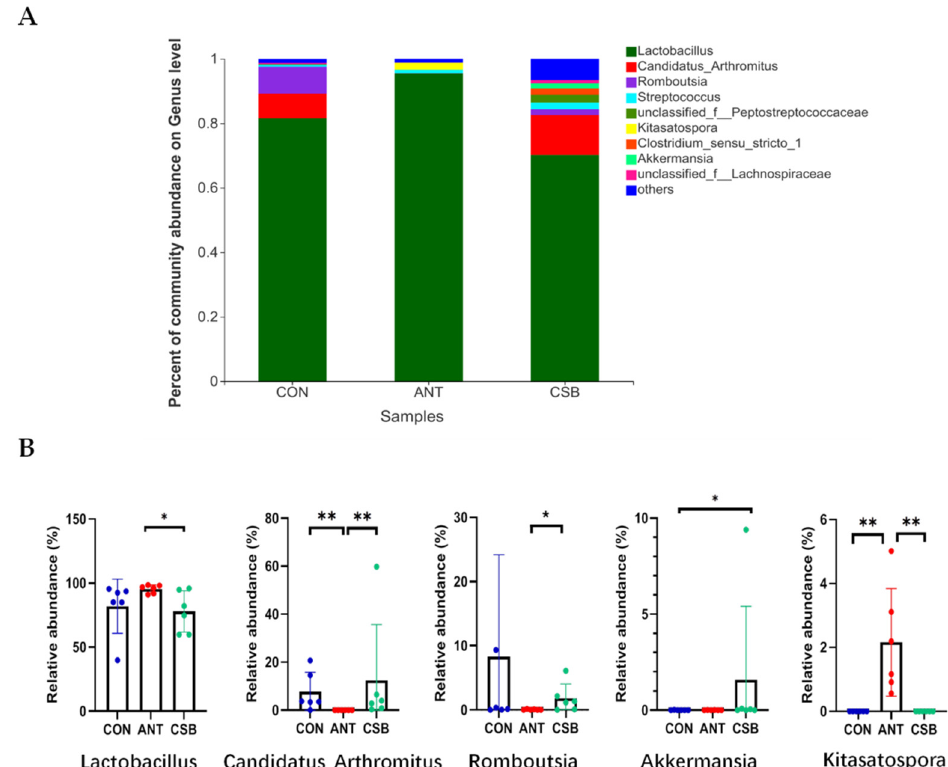
Figure 7. Effects of CSB on the ileal microbial community at the genus level in broilers at 21 d of age ( n = 6). ( A ) Percent of community on genus level. ( B ) Comparative analysis of relative abundance of major bacterial at genus level. * 0.01 < p ≤ 0.05, ** 0.001 < p ≤ 0.01.